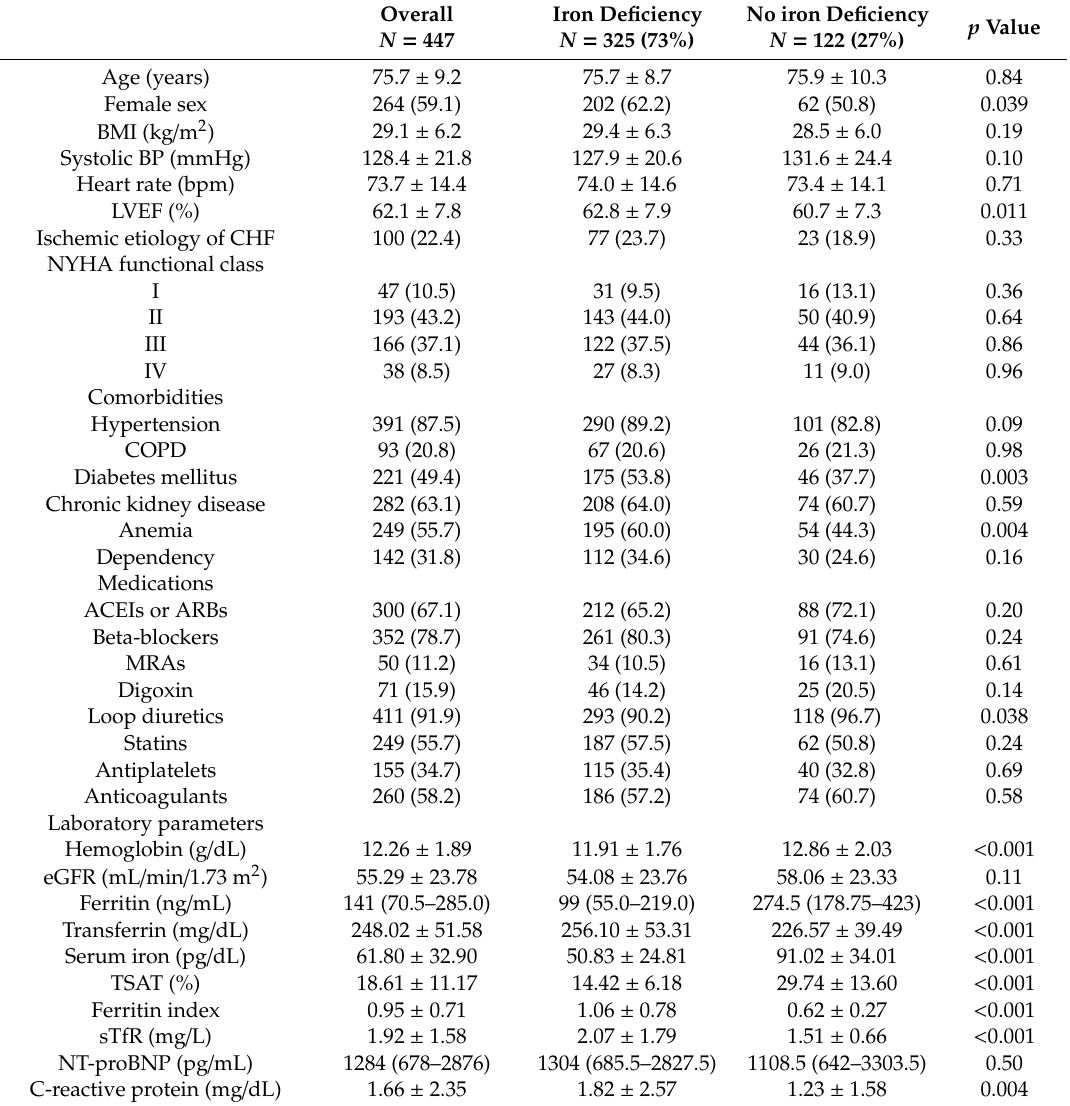
Table 1. Baseline characteristics of HFpEF patients according to